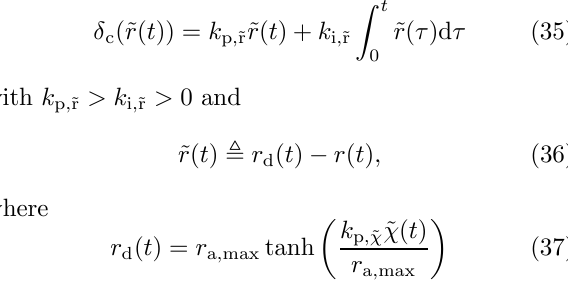
Figure 11: Pro fi le of desired yaw rate as a function of course error for varying  p  ˜ 